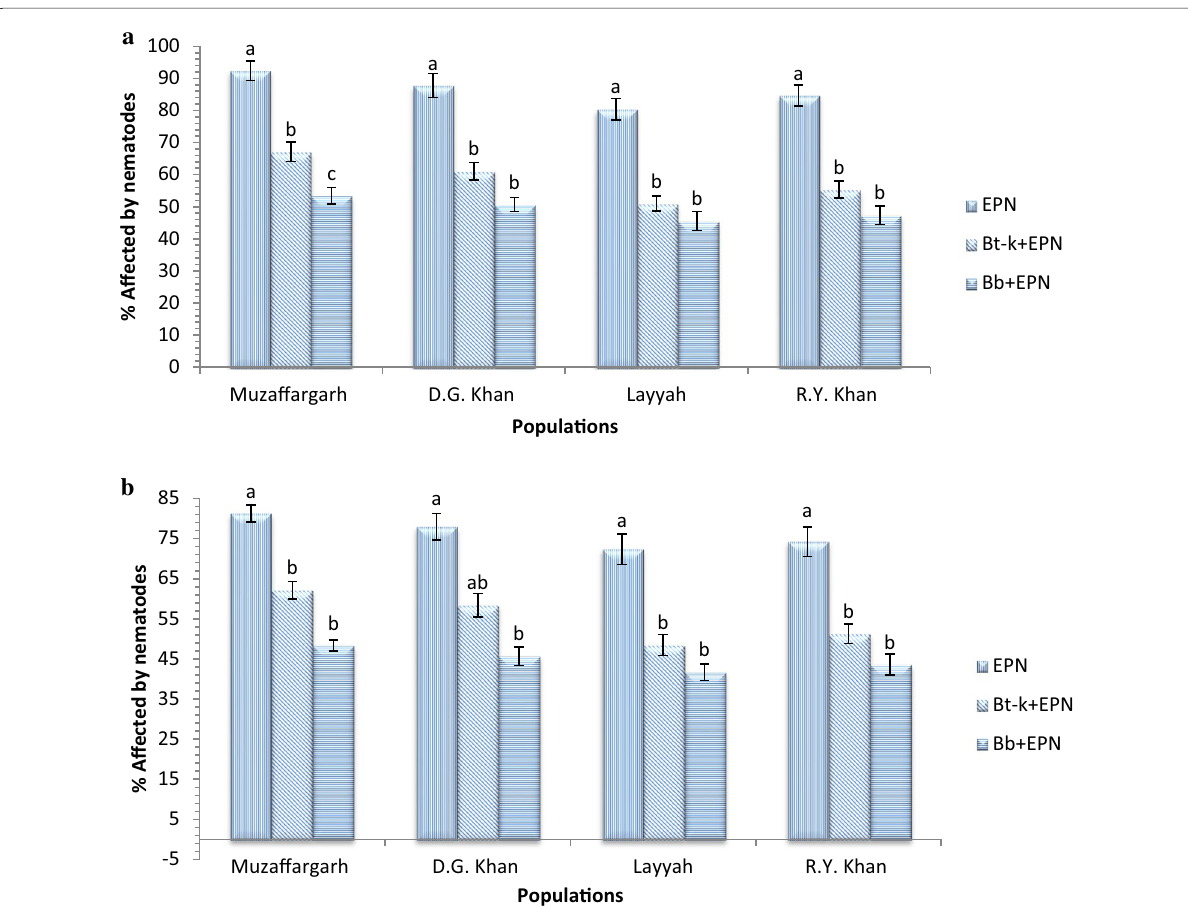
Fig. 3 a Rhynchophorus ferrugineus larvae affected by Heterorhabditis bacteriophora treated with Bt-k (70 µg g − 1 ), Beauveria bassiana (1 conidia ml − 1 ) and Heterorhabditis bacteriophora (300 IJs ml − 1 ) applied alone or in combination. Treatments followed by the same letter within each treatment are not significantly different; HSD test P 0.05 ( Bt-k : Bacillus thuringiensis var. kurstaki , Bb: Beauveria bassiana , EPN: Heterorhabditis ≤ bacteriophora ). b Rhynchophorus ferrugineus adults affected by Heterorhabditis bacteriophora treated with Bt-k (70 µg g − 1 ), Beauveria bassiana (1 10 7 conidia ml − 1 ) and Heterorhabditis bacteriophora (300 IJs ml − 1 ) applied alone or in combination. Treatments followed by the same × letter within each treatment are not significantly different; HSD test